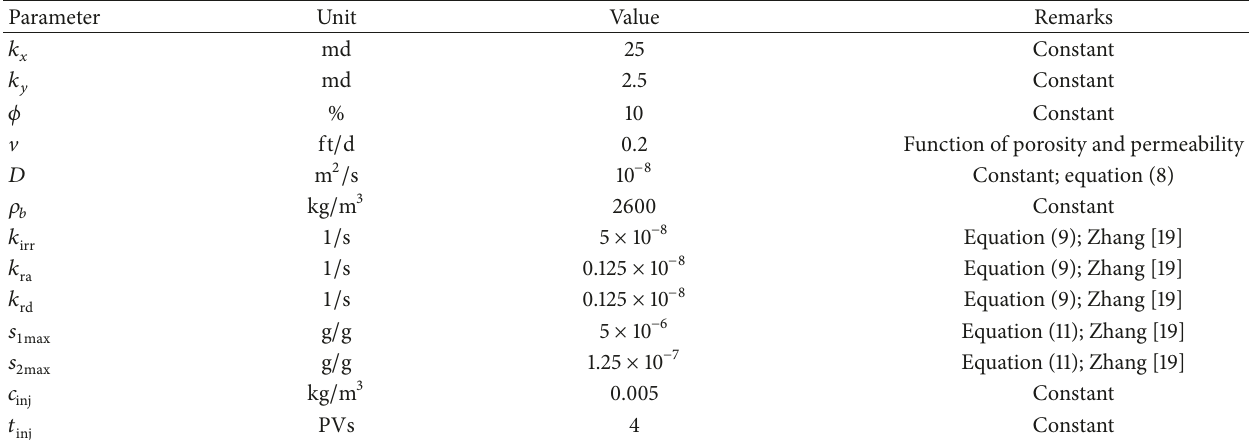
Table 1: Baseline parameters for six cores at laboratory